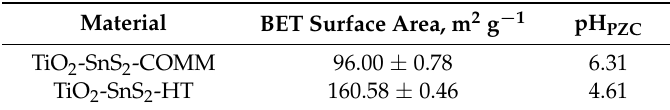
Table 3. Surface properties (specific surface area and point of zero charge values) of studied TiO 2 - SnS 2 composites (72.5:27.5 wt %).